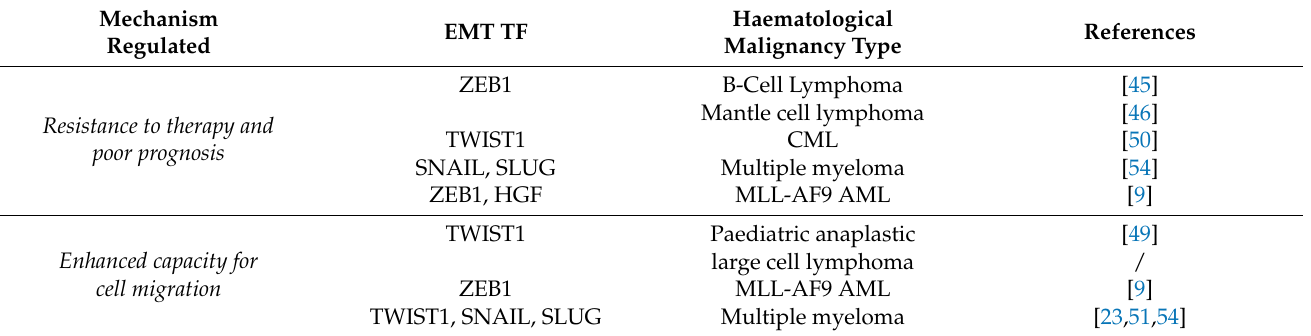
Table 1. Upregulation of canonical EMT markers in haematological malignancies correlates with poor prognosis and/or the enhanced migration of cancer